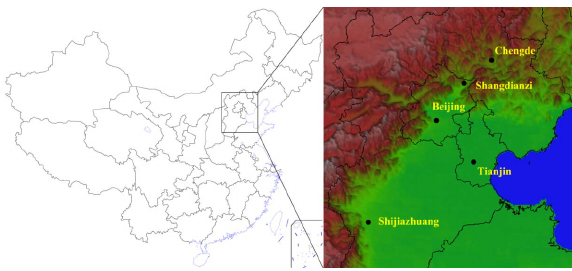
Figure 1. Sampling sites of PM 2.5 . Fig. 1. Sampling sites of PM 2 . 5